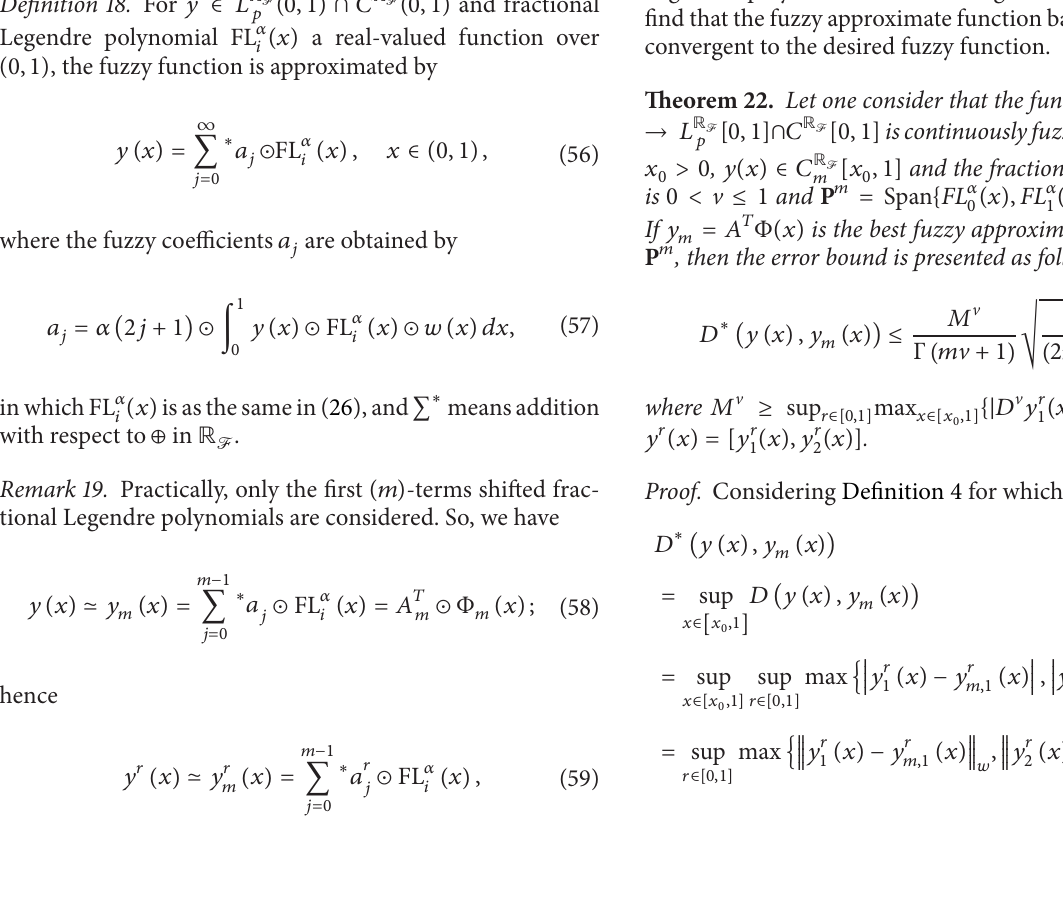
polynomials. For more details about the fuzzy approximation functions, see